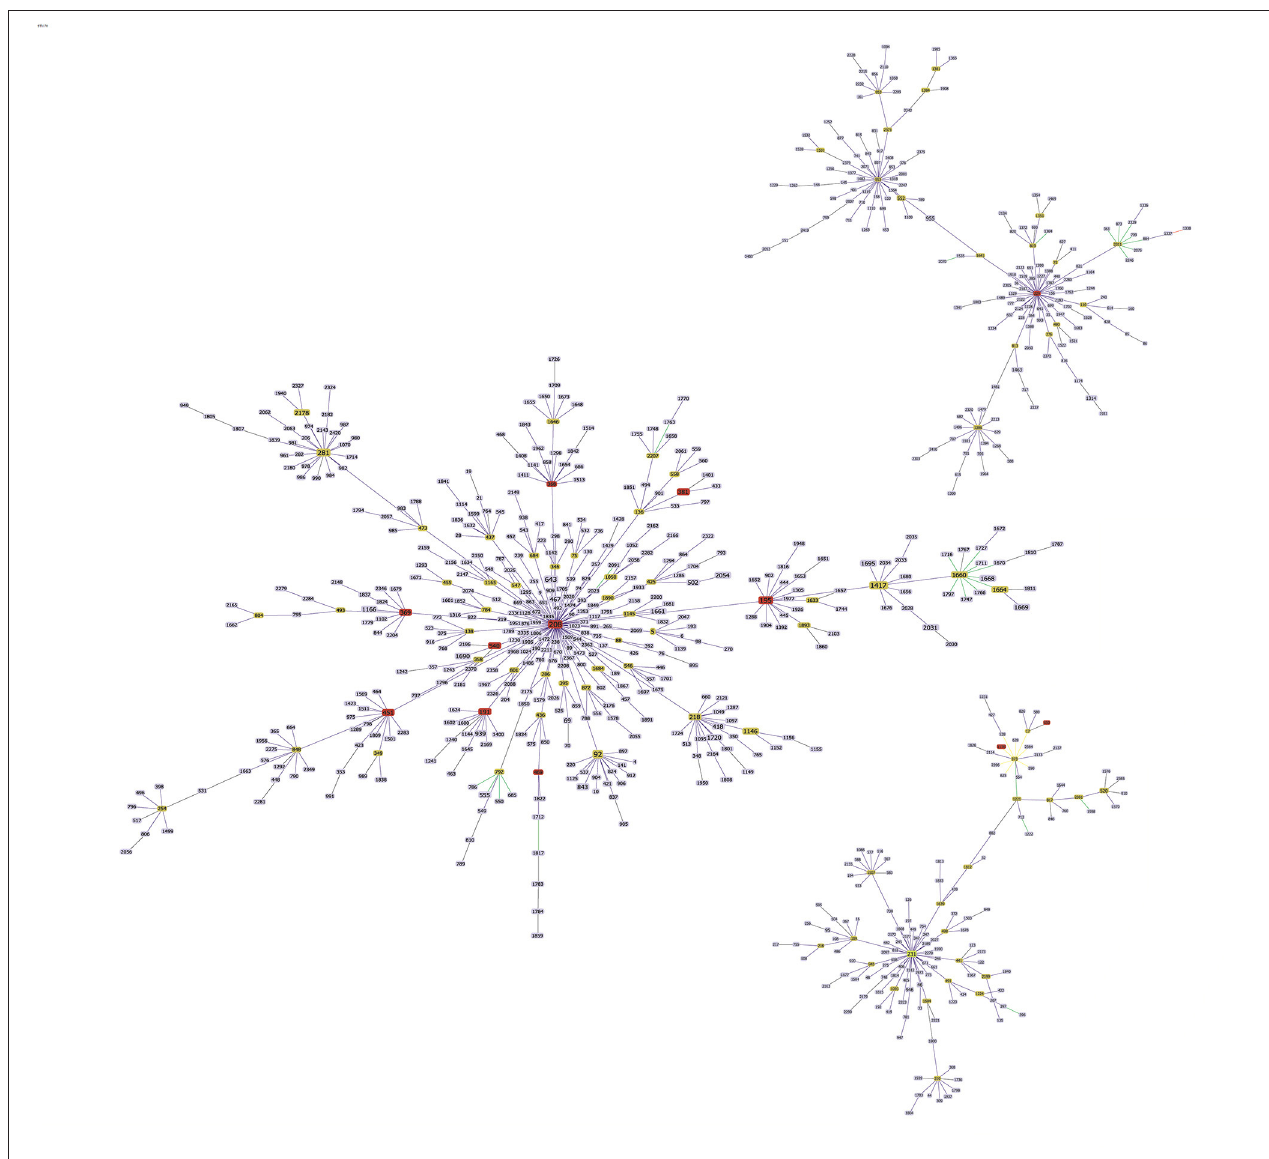
FIGURE 1 | eBURST analysis of 295 MDR Acinetobacter baumannii isolates. It was found that these 12 STs could be divided into three groups. ST369, ST208, ST195, ST191, ST368, ST469, ST451, ST381, and ST540 belonged to Group 1, and ST208 was the central type. ST229 belonged to Group 2, and ST530 and ST1176 constituted Group